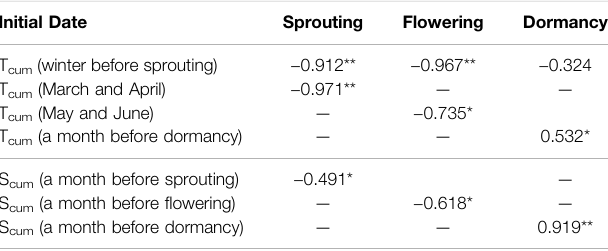
TABLE 3 | Pearson correlation analysis between the key phenological stages and the key environmental